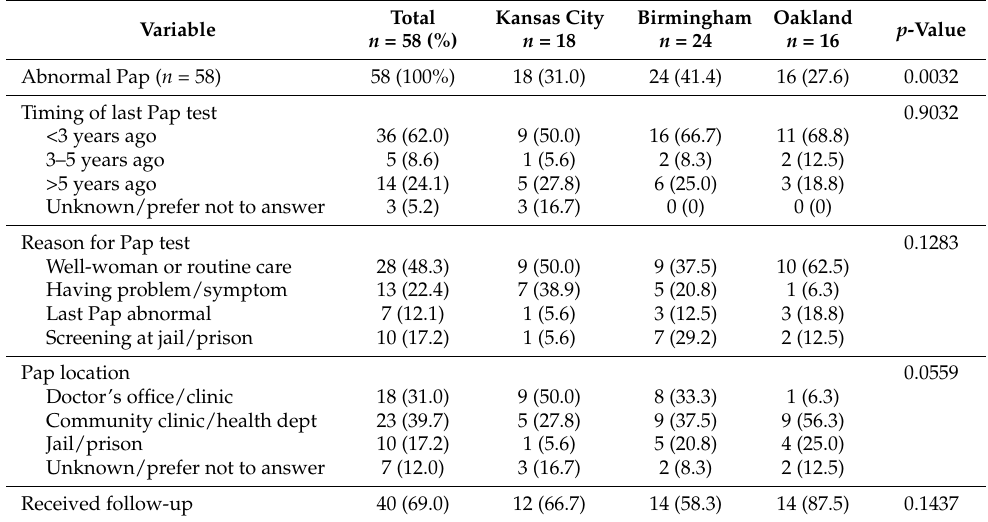
Table 1. Criminal-legal system involved women who reported abnormal results at time of last Pap test according to study site.